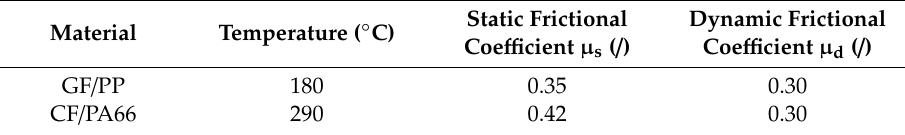
Table 3. Static and Dynamic Frictional coe ffi cients calculated for GF / PP and CF / PA66.